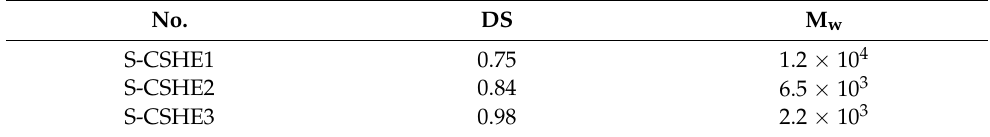
Table 3. Molecular weight value of the samples.